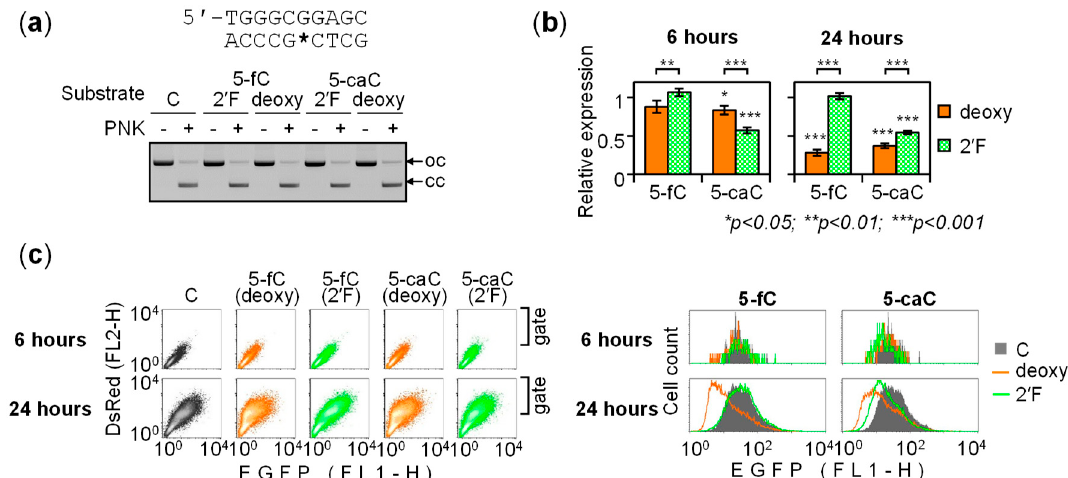
Figure 4. Effects of BER-resistant analogs of 5-fC and 5-caC in the pyrimidine-rich strand on the GC box activity. ( a ) Agarose gel electrophoresis of the fully ligated deoxy and 2 ′ F constructs and the respective “no PNK” controls. The open circular (oc) and covalently closed (cc) forms of the vector are indicated by arrows. ( b ) Relative expression of the 5-fC and 5-caC (deoxy versus 2 ′ F) constructs 6 and 24 h post-transfection (mean ± SD, n = 4 independent experiments). ( c ) A representative flow cytometry experiment: two-dimensional fluorescence scatter-plots (left) and the derived EGFP fluorescent distribution plots for the indicated transfection condition (right panels, samples overlaid).